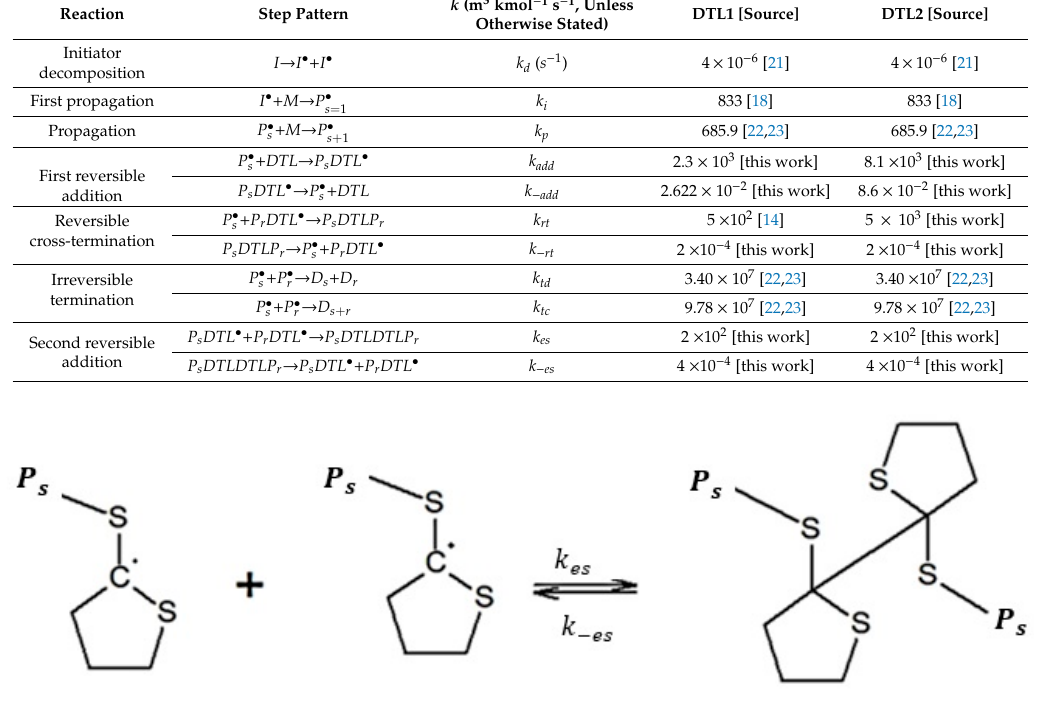
Figure 6. Second reversible addition reaction. Table 1. Polymerization scheme and kinetic rate constants used.